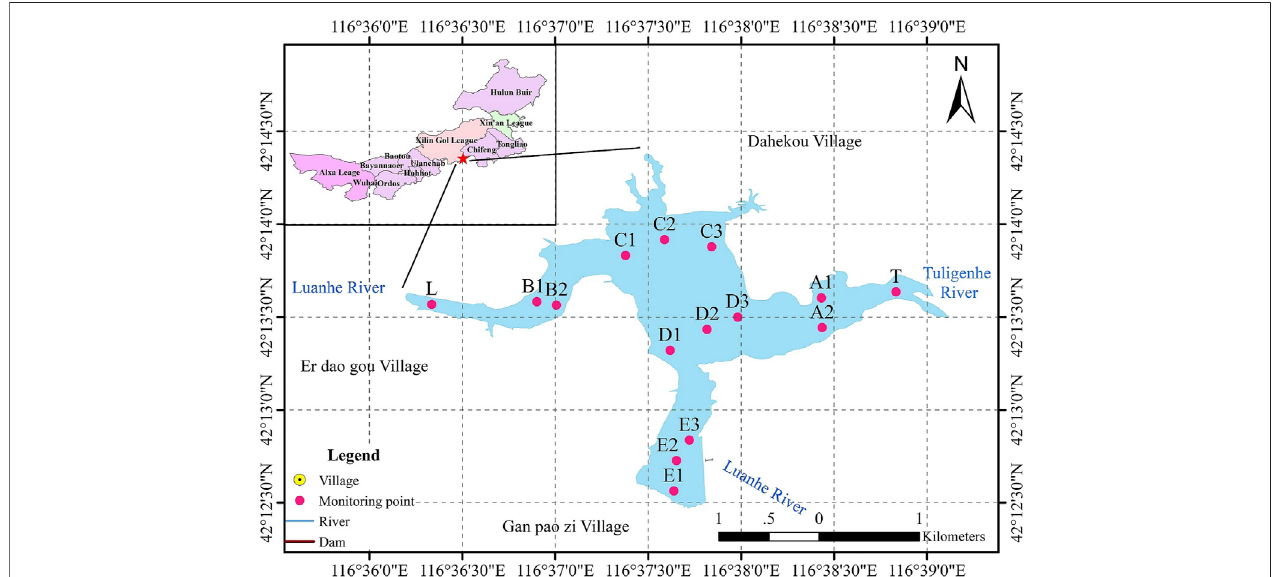
FIGURE 1 | Layout of the monitoring points in the Dahekou